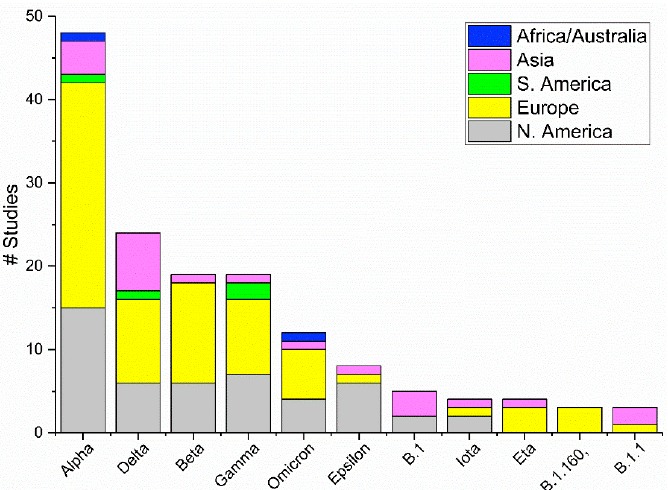
Figure 4. Number of studies targeting or detecting different SARS-CoV-2 variants. Variants are included in the figure only if they are detected by three or more studies.